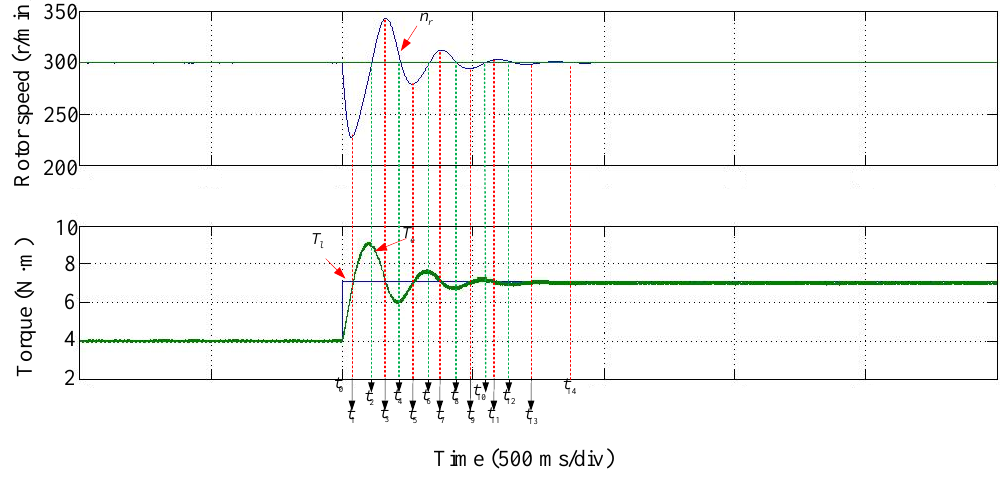
Figure 8. The dynamic process under a sudden load sudden for the direct torque control (DTC).